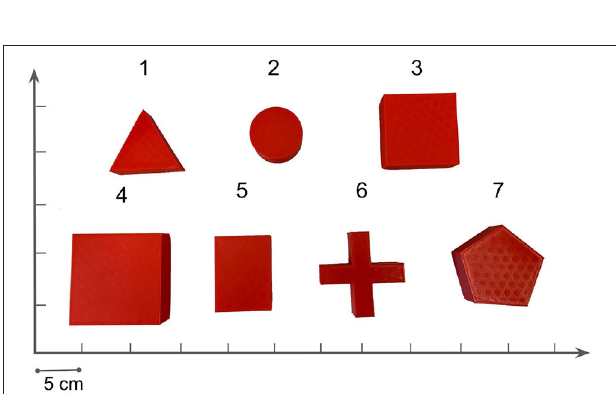
FIGURE 11 | Illustration of 7 tested objects in the real experiments. Object numbered from 1–3 are training objects in the simulation. Object 4 and 5 have similar shapes but different size with the training objects, but object 6 and 7 are novel in shape.